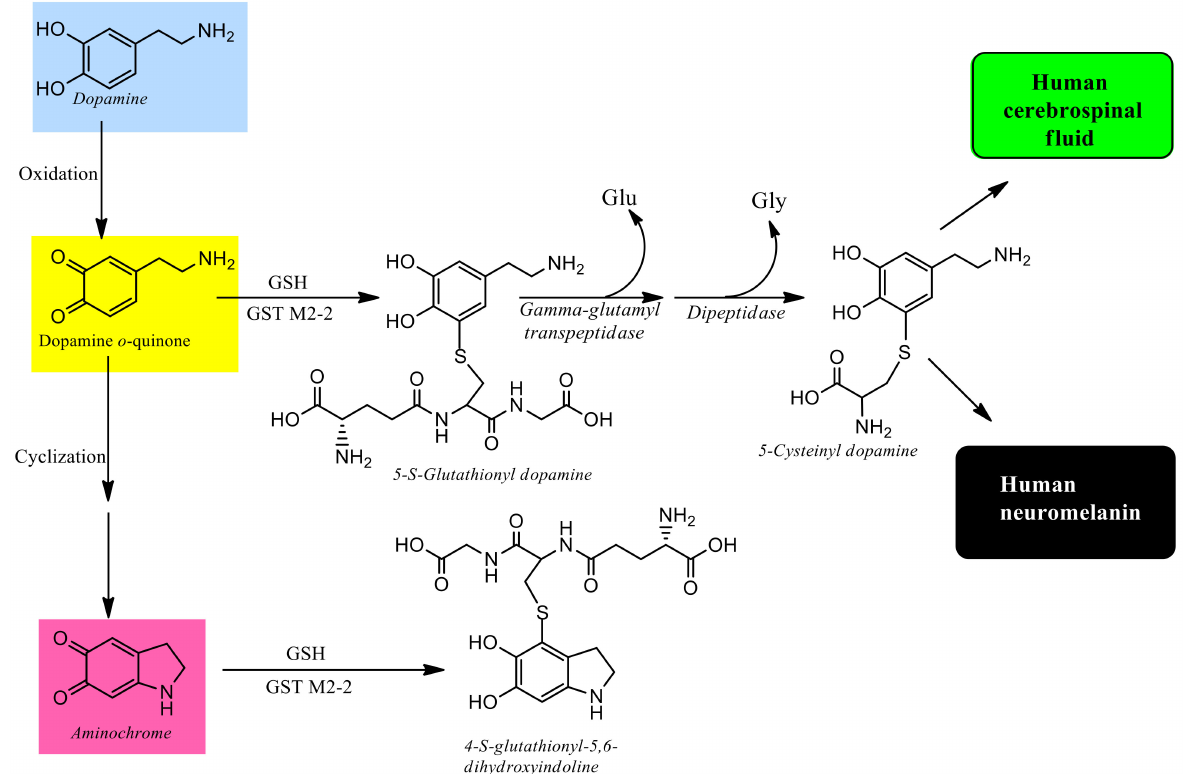
Figure 4. Aminochrome conjugation with glutathione. Glutathione transferase M2-2 catalyzes glutathione conjugation of dopamine o -quinone to 5-S-glutathionyl dopamine, which degrades to 5-cysteinyl dopamine. 5-cysteinyl dopamine has been found in neuromelanin and human spinal brain fluid, suggesting that it is a final product. Glutathione transferase M2-2 also catalyzes the conjugation of aminochrome with glutathione to 4-S-glutathionyl-5,6-dihydroxyindoline, which is resistant to biological oxidizing agents such as dioxygen, superoxide, and hydrogen peroxide. The aminochrome conjugation prevents neurotoxic effects and appears to be a major neuroprotective